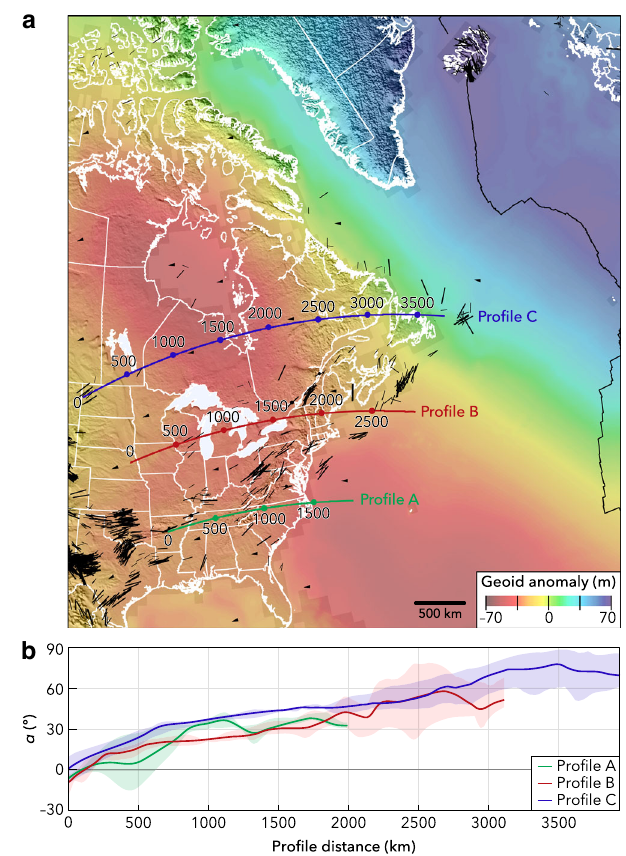
Fig. 2 Relationship between absolute plate motion directions and maximum horizontal stress ( S Hmax ) orientations in central and eastern North America. a Stress map subset with pro fi les parallel to absolute plate motion. b Angle α , the mean divergence between S Hmax orientations and plate motion, was sampled every 0.1° along 4°-wide swath pro fi les from a slightly smoothed grid of divergence angles. The shaded regions represent the full range of divergence angles sampled across each swath pro fi le. Divergence angles were estimated by subtracting interpolated A and B quality S Hmax orientations from NNR-MORVEL56 30 plate